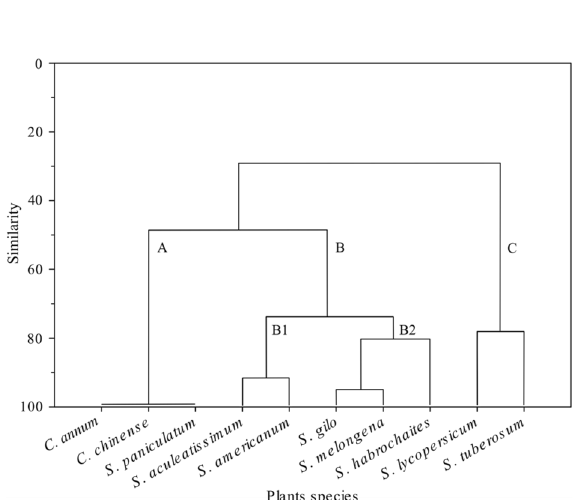
Figure 4. Dendrogram of solanaceous species clustered according to T. absoluta performance (oviposition preference, larval mortality, pupal weight, and adult fecundity) when reared on the different plant